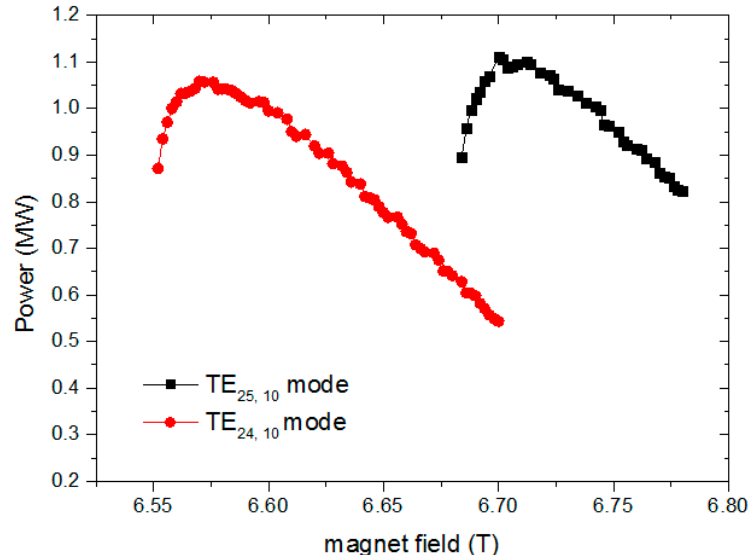
Figure 5. Simulation result of the gyrotron with cavity parameters listed in Table 3. The TE 25,10 mode and TE 24,10 mode oscillate in the nearby magnetic field. Table 3. Design parameters for resonator of 170 GHz gyrotron.